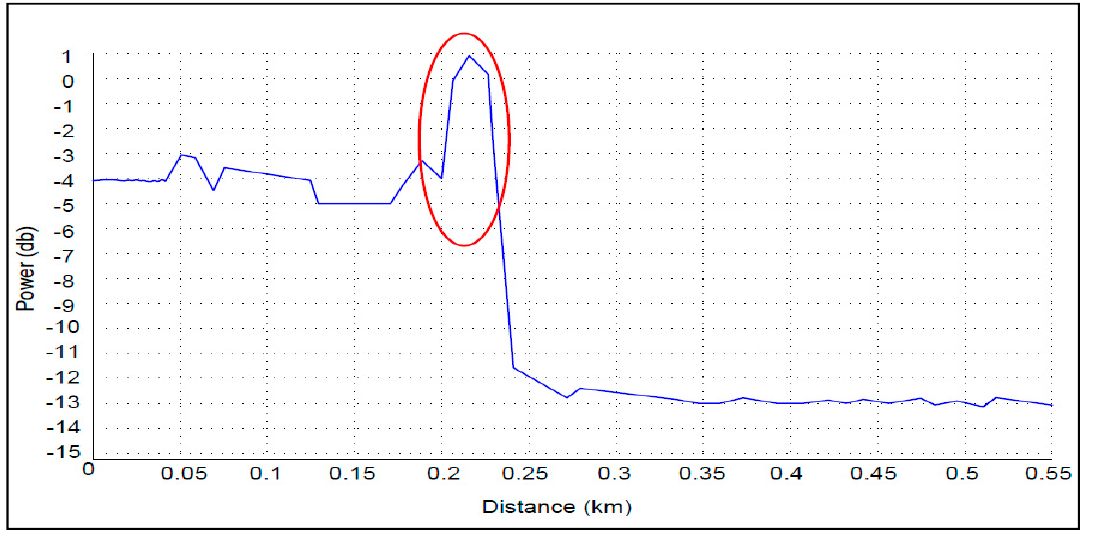
Table 6. The parameters and practical results detected at event 2.